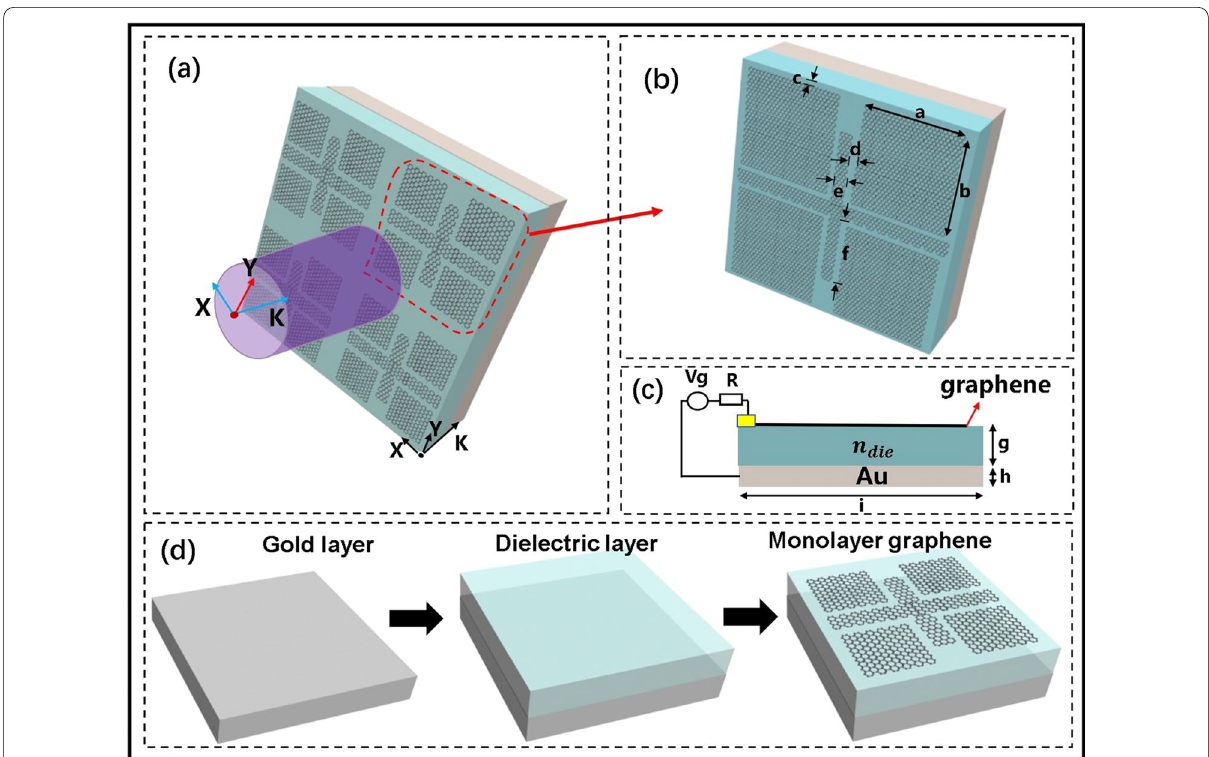
Fig. 1 a Patterned structure of periodic monolayer graphene. b Single-layer graphene patterned unit structure. c The cross-sectional view of the structure and circuit diagram. d Preparation diagram of the provided structure metamaterial. Here, the geometric parameters of the structure are as follows: a b 1.5 μm, c d 0.2 μm, e 0.3 μm, f 1.4 μm, i 4 μm; g 1.6 μm, h 0.5 μm = = = = = = = = =